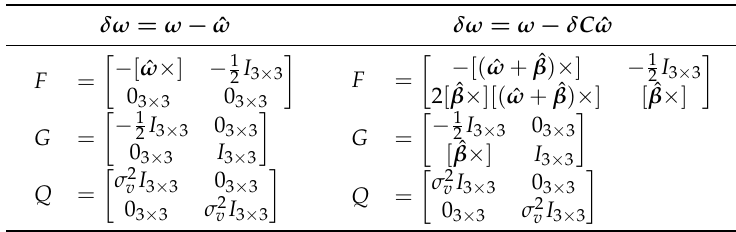
Table 2. The extended Kalman filter (EKF)